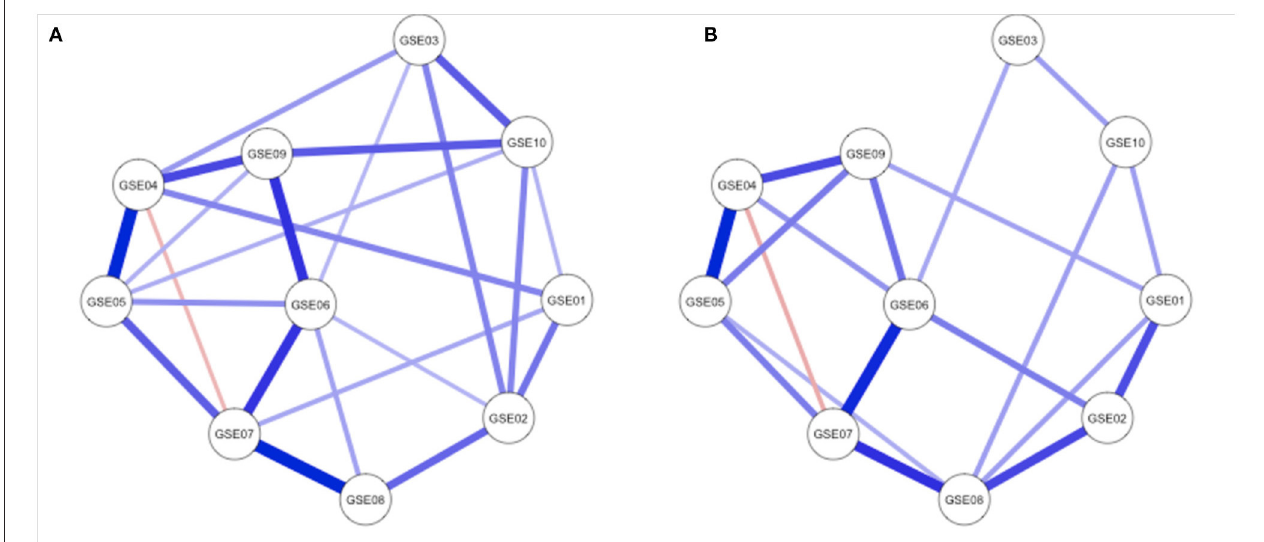
FIGURE 2 | Regularized partial correlation networks of (A) the high resilient functioning group ( n = 467) and (B) the low resilient functioning group ( n = 408). Network nodes refer to the items of the General Self-Efficacy Scale ( 43). Edges show regularized partial correlations between all ten questionnaire items (GSE01 until GSE10). A thicker line indicates higher correlations. No line indicates that the correlation between this respective pair of nodes was did not survive